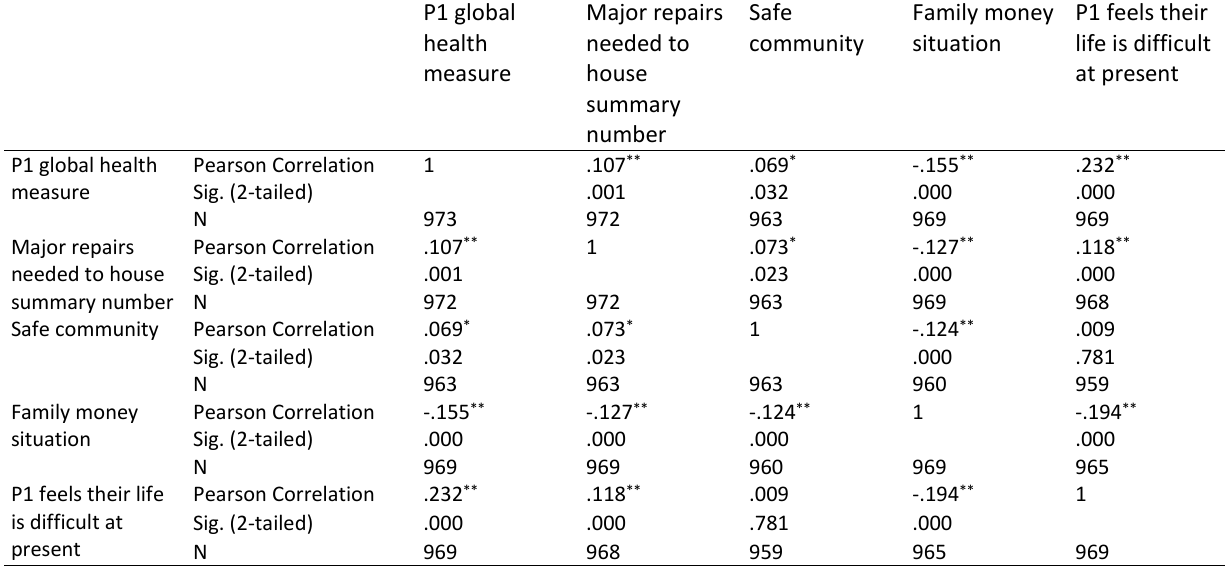
Table 6. Correlations between social exclusion